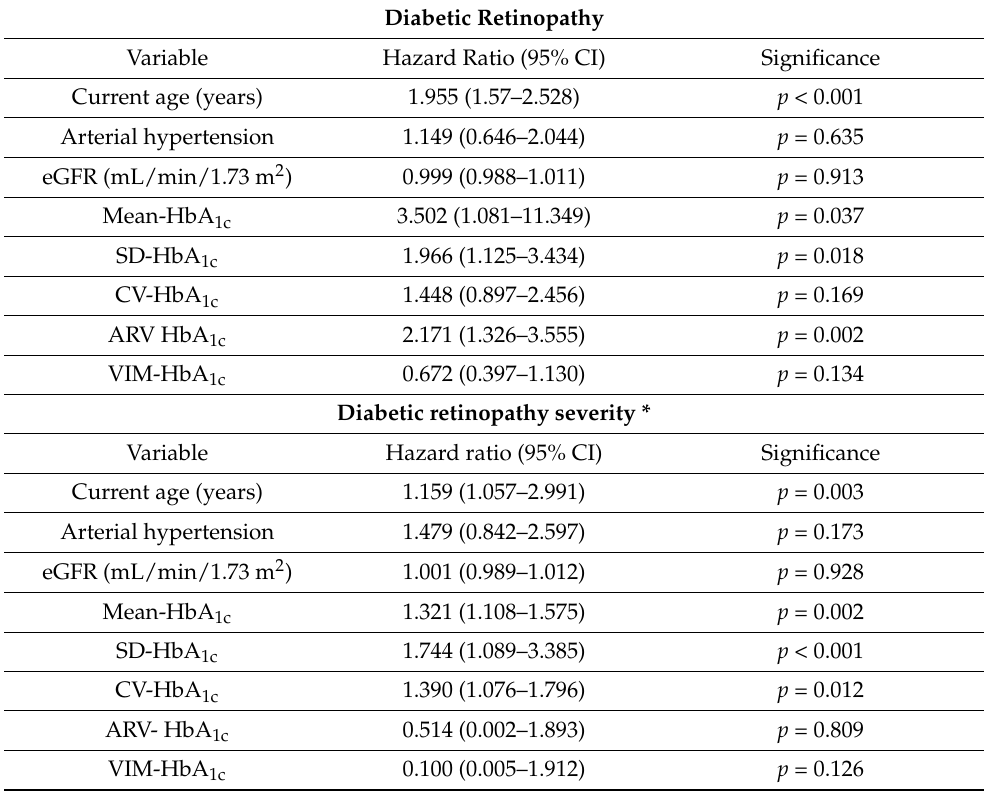
Table 4. Survival study of diabetic